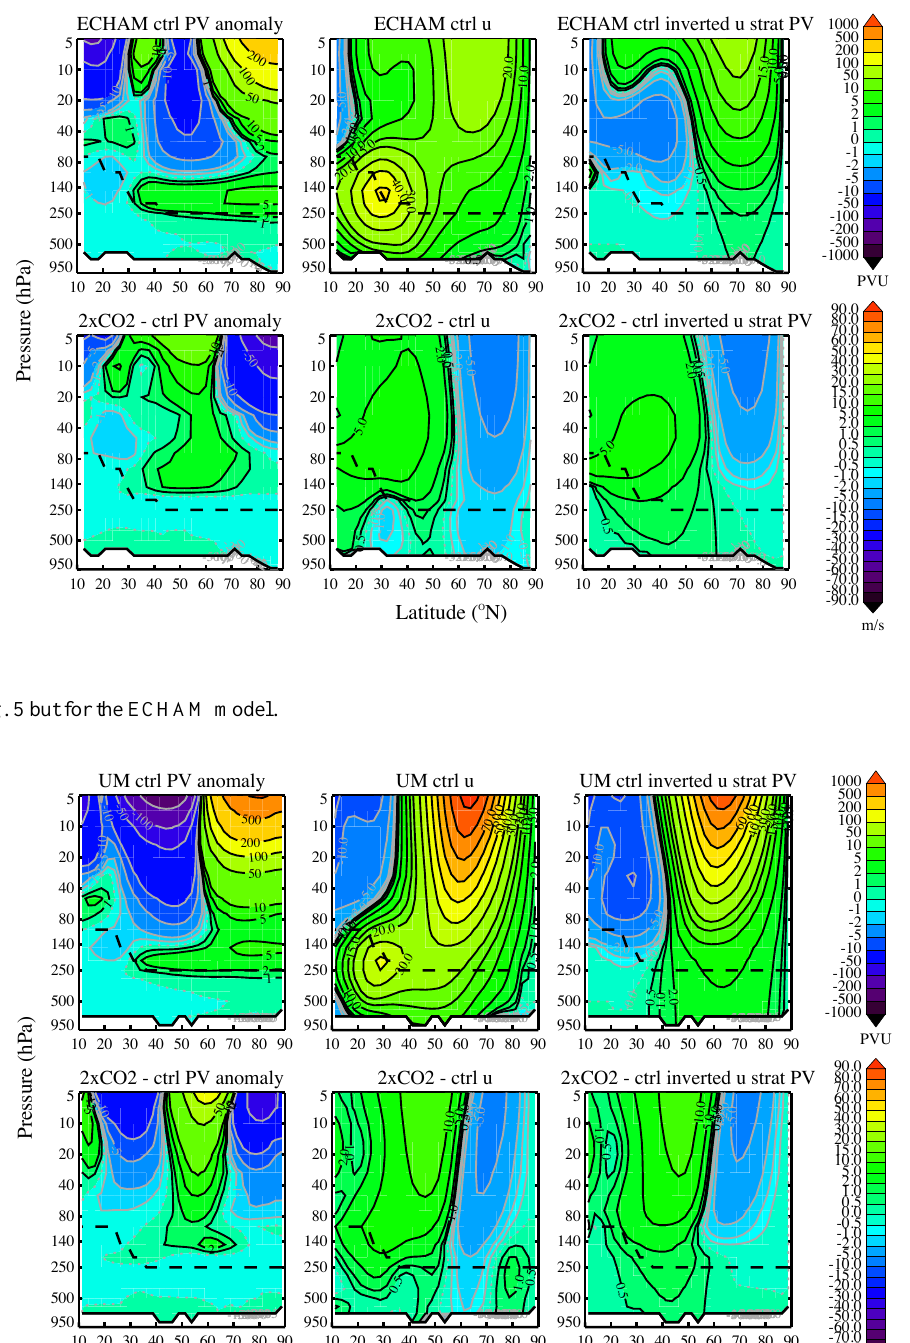
from inversion of the stratospheric PV above 400 K is shown in the right column of Fig. 5. The stratospheric PV changes induce stratospheric wind changes, but also affect the high